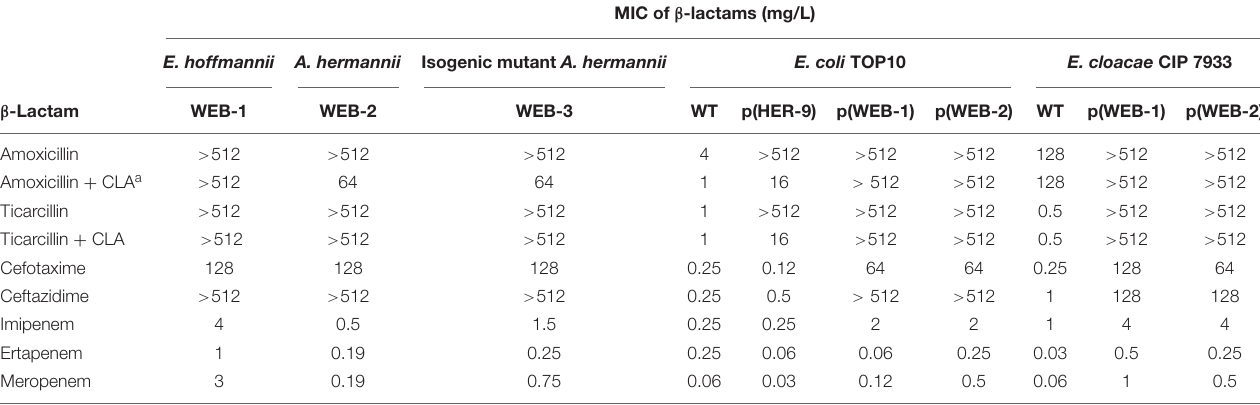
TABLE 2 | MIC of β -lactams for E. hoffmannii WEB-1, A. hermannii WEB-2, isogenic mutant A. hermannii WEB-3, E. coli TOP10 wild type (WT), and recombinant E. coli isolates with plasmids from E. hoffmannii WEB-1 and from A. hermannii WEB-2 and for E. cloacae CIP7933 and recombinant E. cloacae isolates with plasmids from E. hoffmannii WEB-1 and from A. hermannii